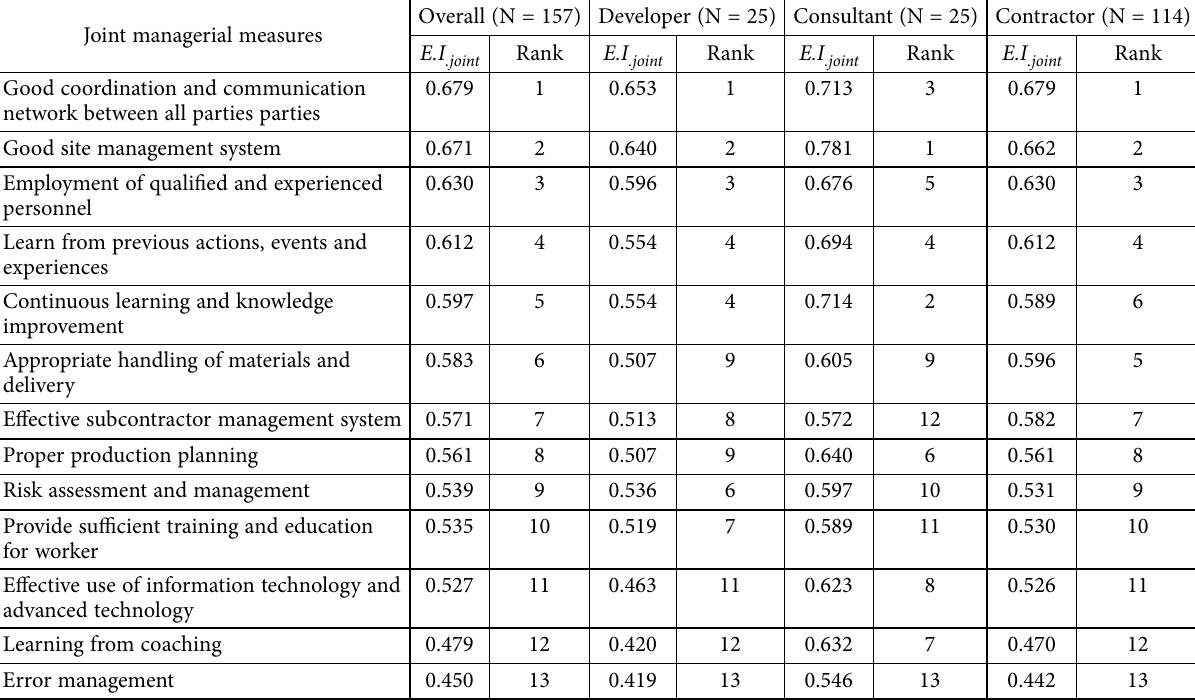
Table 5. Joint effectiveness index and ranking for rework and safety management measures Joint managerial